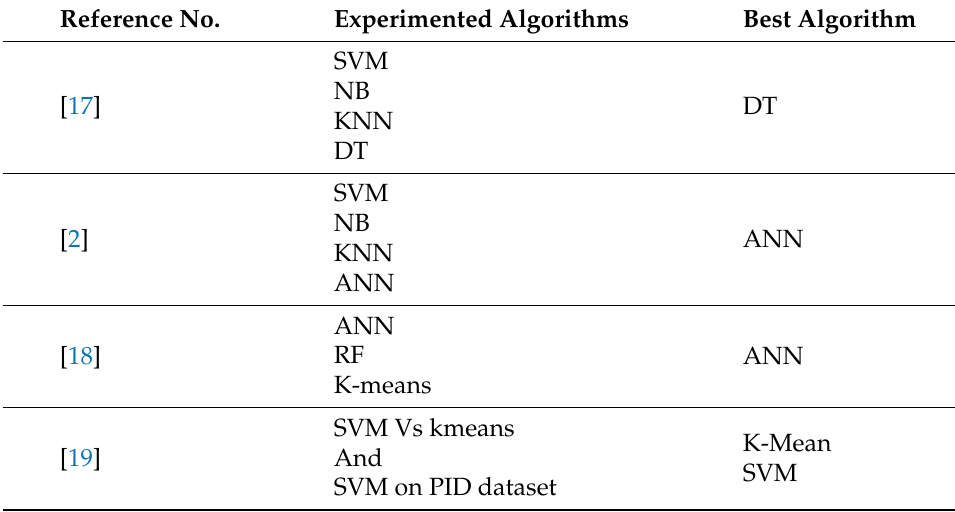
Table 5. Summary from previously conducted research in diabetes prediction. Reference